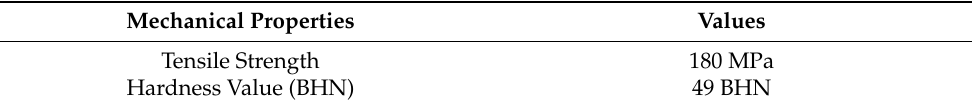
Table 2. Mechanical properties of Al6082